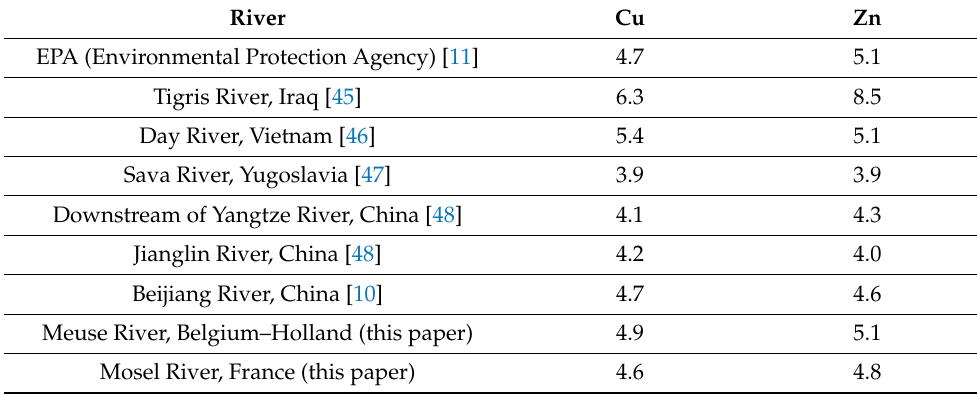
Table 2. The mean partitioning coefficients (lgKd) of trace metals in some rivers of the world. River Cu Zn EPA (Environmental Protection Agency)